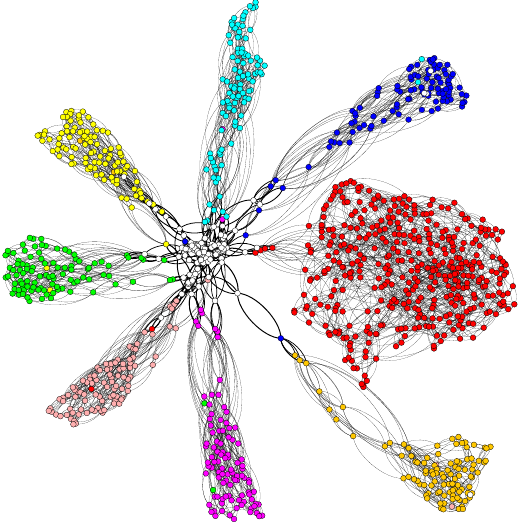
Figure 7. Visualization of a low degree graph created from a D8K8 dataset. Different colors represent different ground-truth clusters. White nodes are noise (note the large number of noise nodes at the center of the graph).